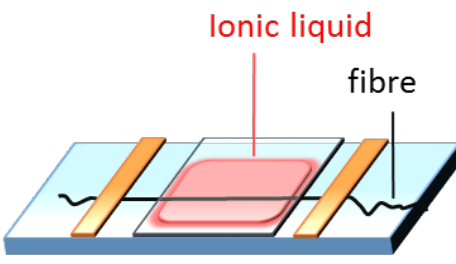
Figure 7. Schematic illustration of the sandwich structure for observation of a single wool fibre dissolution under